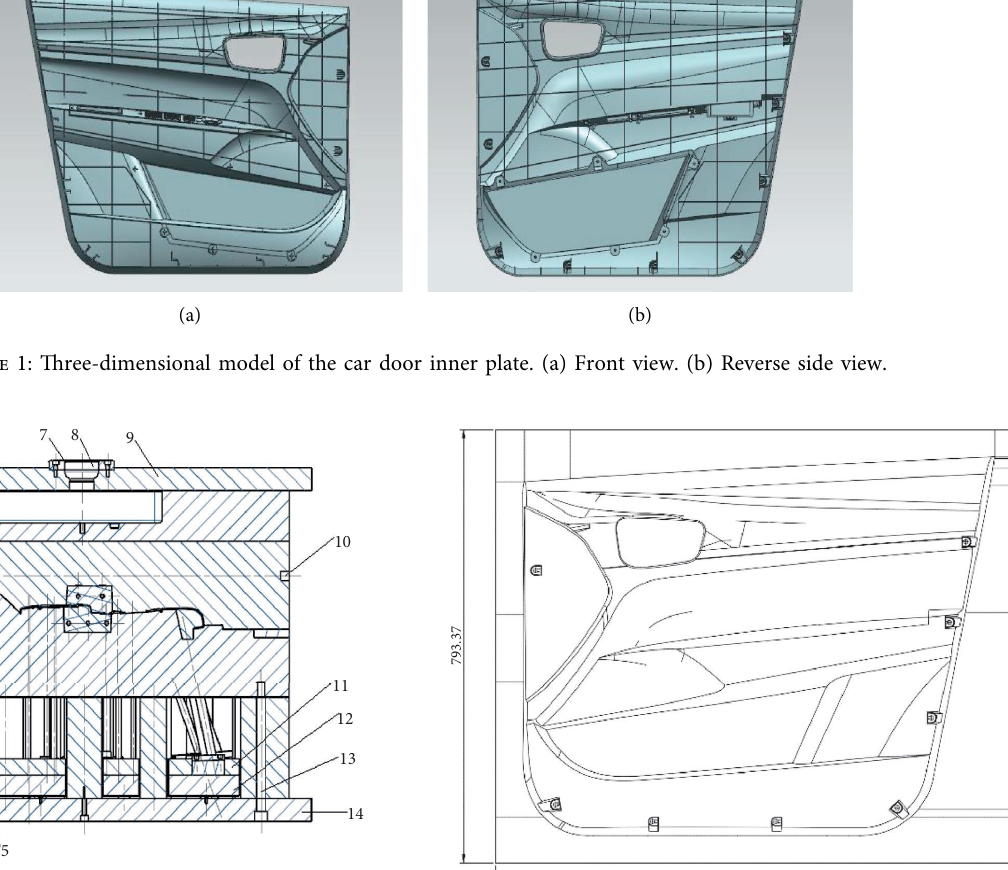
Figure 2: Die assembly drawing of the car door inner plate.